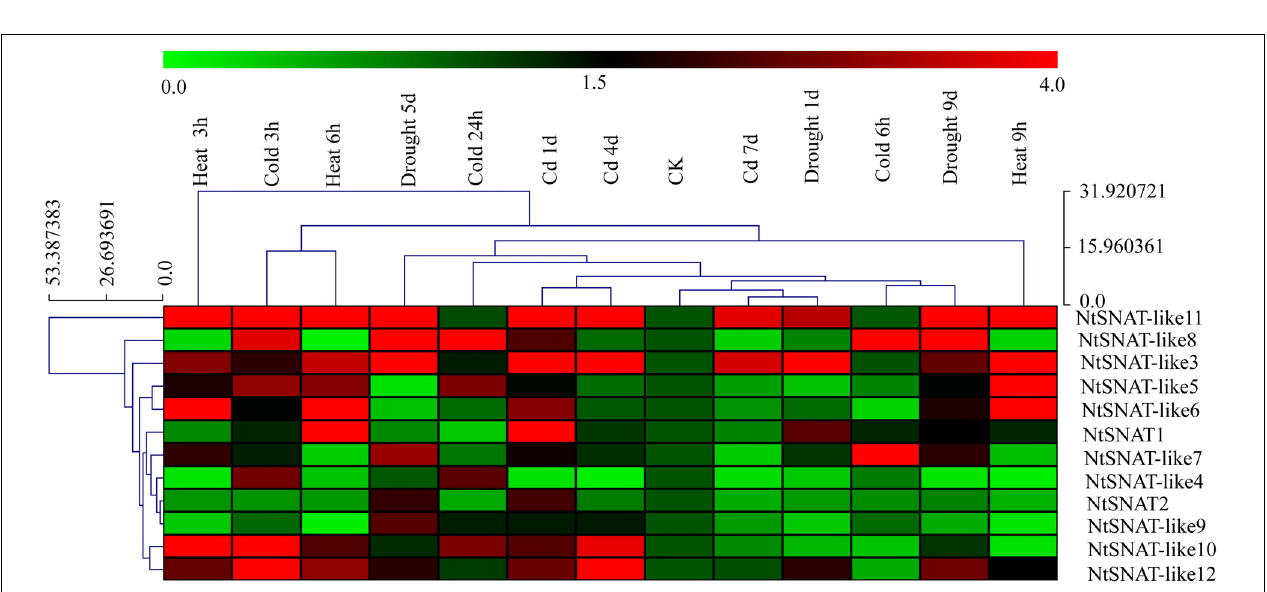
FIGURE 5 | Hierarchical cluster display of expression profiles of NtSNAT and NtSNAT -like genes in tobacco leaves in response to drought, heat, cold, and cadmium (Cd) treatments. The blocks with colors indicate low (green) or high (red) transcript accumulation.